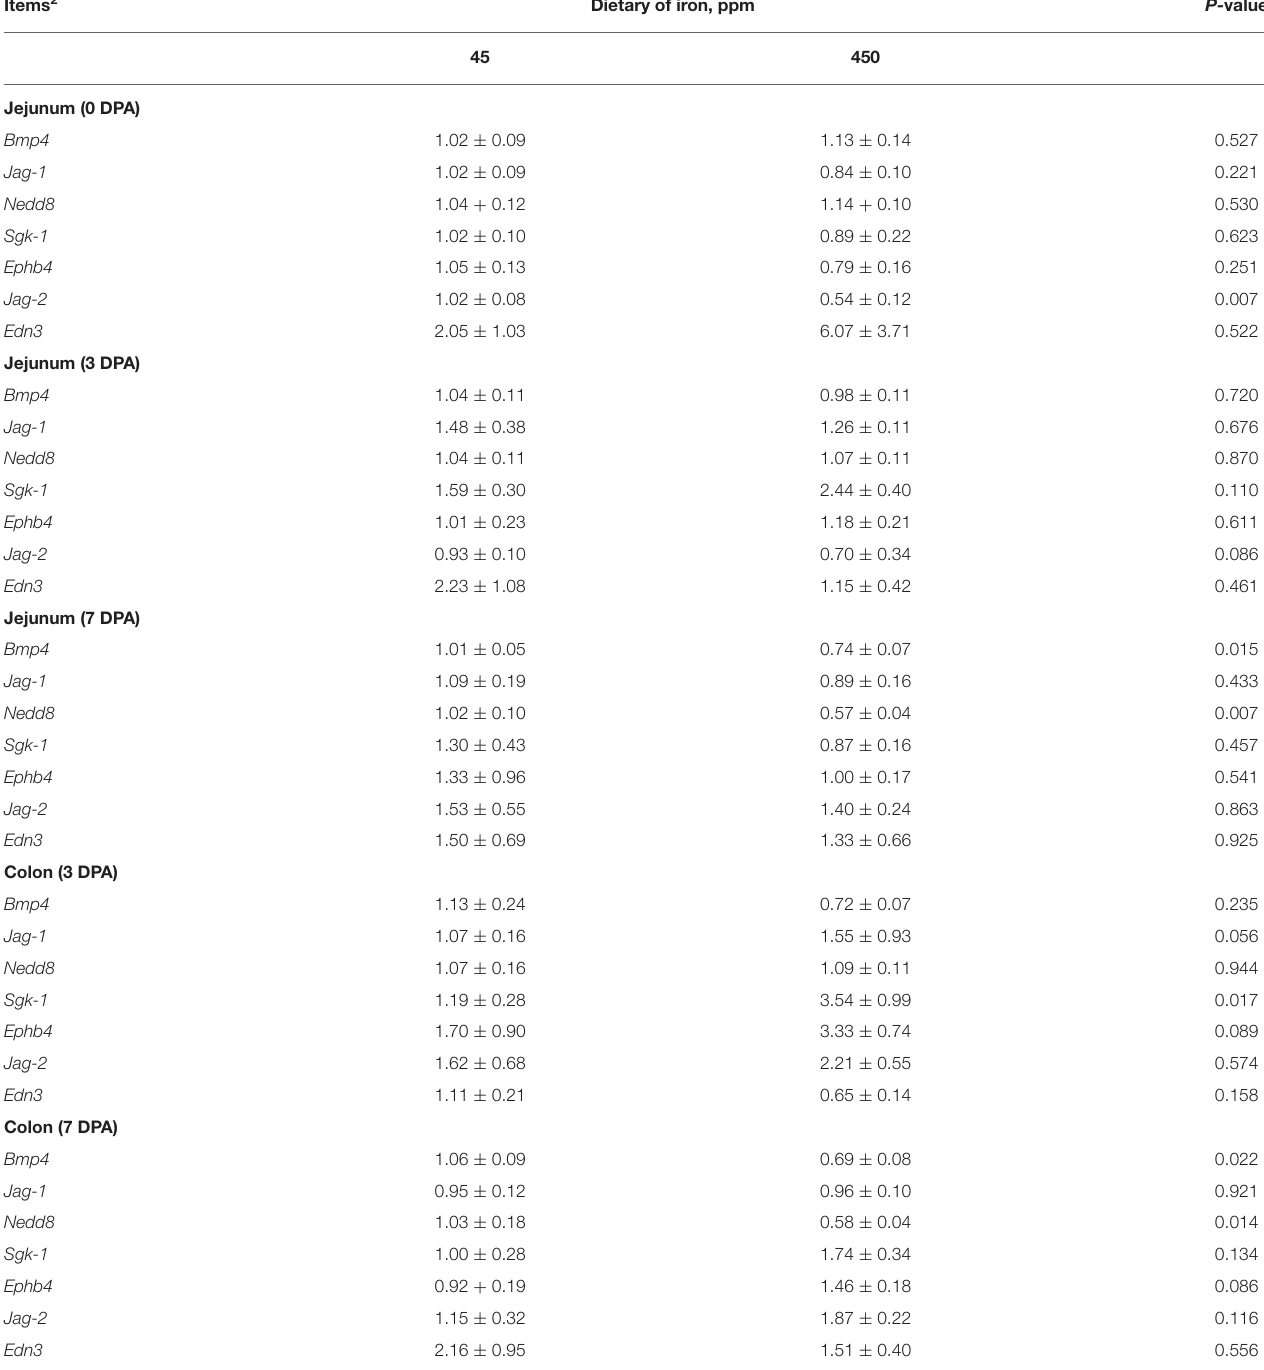
TABLE 3 | Effects of dietary iron on Wnt target gene in adult mice 1